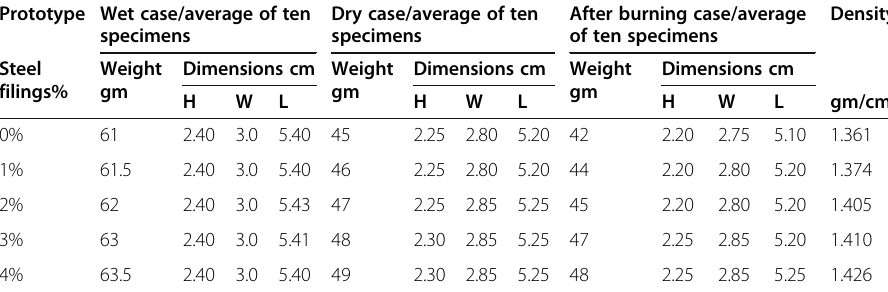
Table 2 Results of dimensions, weight, and density tests Prototype Wet case/average of ten Dry case/average of ten specimens specimens